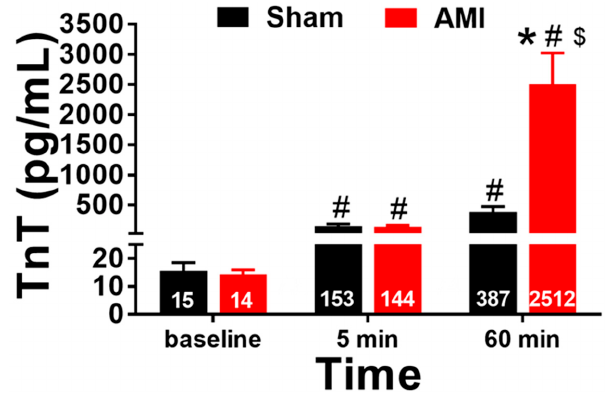
Figure 6. Troponin T (TnT) levels before coronary occlusion (baseline) and after 5 and 60 min of artery reperfusion in the AMI group (n = 9) and at the equivalent times in the sham group (n = 7). * p < 0.05 compared with sham, # p < 0.05 compared with preocclusion (baseline), and $ p < 0.05 compared with 5 min of reperfusion. Error bars = standard error of mean.